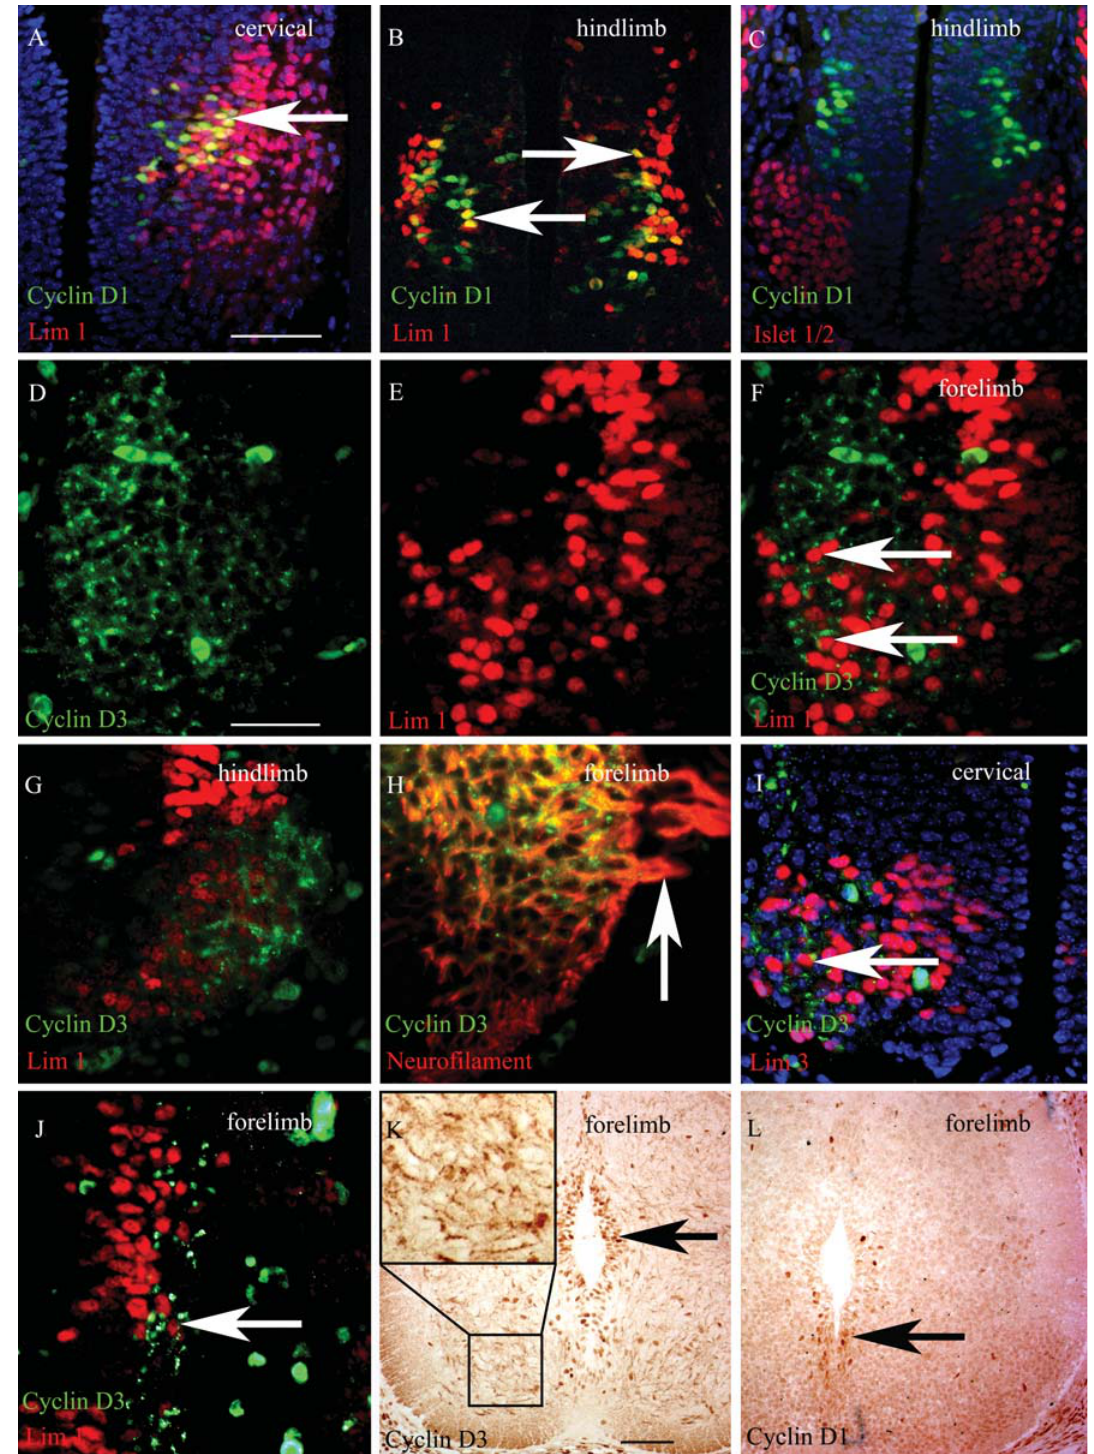
Figure 2 - Sections through the spinal cord (SC) E12.5 embryonic stage showing fluorescent staining (A-J) and through the spinal cord E15.5 embryonic stage showing colorimetric staining (K, L). (A-C) Cyclin D1 (green) co-localizes with Lim1 (red; A, B, arrows), but not with Islet 1/2 (red; C). (D-G) Cyclin D3 (green) is expressed ventrally in Lim1 (red) positive cells at the forelimb (D-F) and the hind limb level (G). In (F) the overlay of (D) and (E) is shown.(H)CellsexpressingcyclinD3showneurofilament(red)positiveaxonextensionstypicalofmotorneurons(arrow).(I)CyclinD3(green)positive ventro-lateral motor neurons expressing Lim3 (red, arrow). (J) Dorsal Lim1 (red) positive interneurons expressing cyclin D3 (green, arrow). (K) Cyclin D3 is expressed in cells around the lumen (arrow) and in a punctuated pattern in the whole SC. The inlay shows a ventro-lateral part of the spinal cord at a higher magnification. (L) Cyclin D1 is expressed in cells ventrally of the lumen (arrow). Dorsal on the top; Ventral at the bottom. Scale bars: In A, 50 μ m for A-C; In D, 25 μ m for D-J; In K, 50 μ m for K,